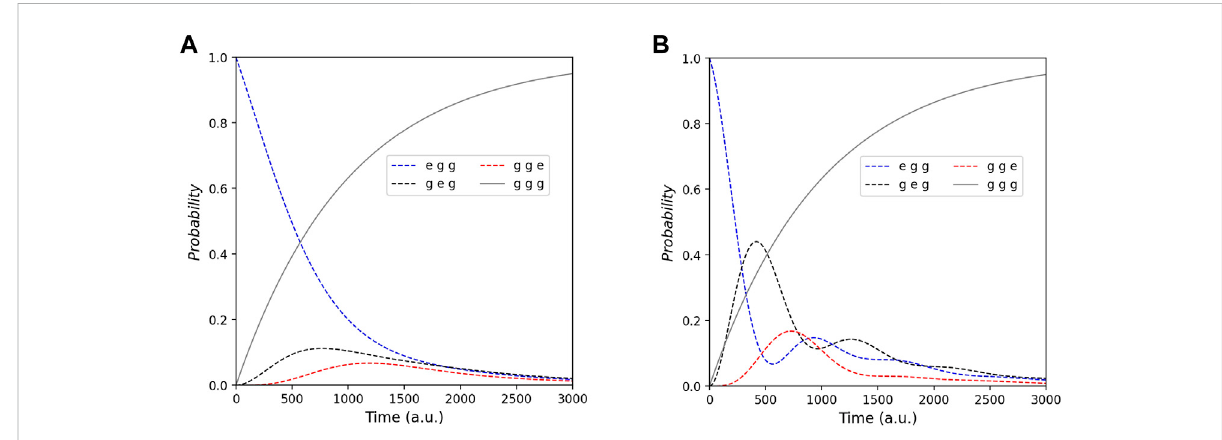
FIGURE 4 Probability of all states that are gge (blue line), geg (black line), egg (red line), and ggg (gray line) at Γ 0 = 0.5 (a.u.). Each picture demonstrates the whole tendency of probability with different λ 1,2 that are (A) 1 and (B) 3